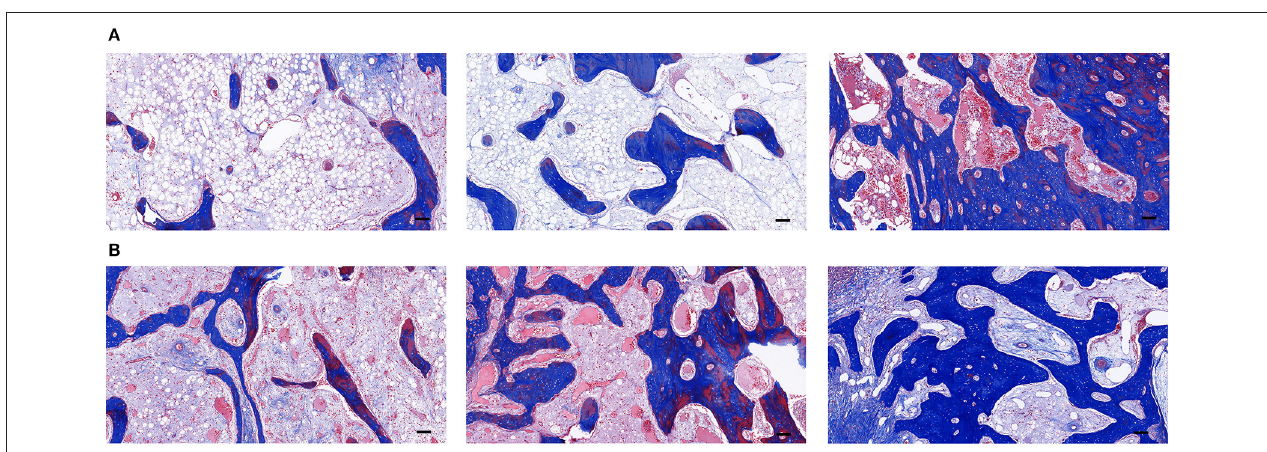
FIGURE 8 | (A) The Masson’s staining of the distraction osteogenesis (DO) region of the mandible in the blank control (group A), the green fluorescent protein (GFP) (group B), and the bone morphogenetic protein 1 (BMP-1) (group C) at three weeks of fixation (Scale: 100 µ m). (B) The Masson’s staining of the distraction osteogenesis (DO) region of the mandible in the blank control (group A), the green fluorescent protein (GFP) (group B), and the bone morphogenetic protein 1 (BMP-1) (group C) at six weeks of fixation (Scale: 100 µ